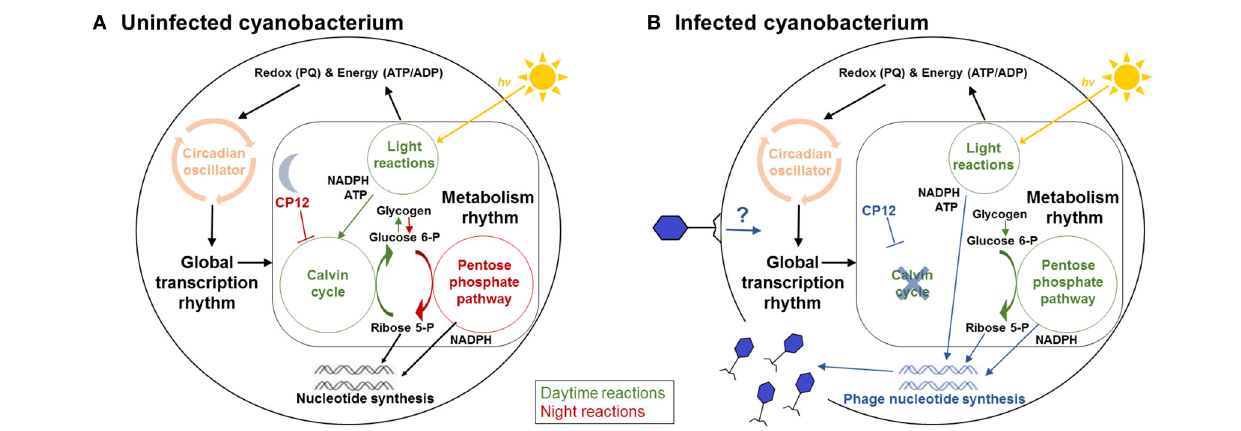
FIGURE 1 | Cyanobacterial metabolism in the uninfected (A) and infected cells (B). (A) In the uninfected host cells, the light reactions of photosynthesis harness energy from the sunlight ( hv ) to produce NADPH and ATP, which are used for carbon fixation in the Calvin cycle. The Calvin cycle is active during the daytime and is inhibited by CP12 at night. The pentose phosphate pathway is mainly active at night. This metabolism rhythm is under the control of the circadian oscillator, which is affected by the intracellular redox (PQ, plastoquinone) and energy (ATP/ADP) state. The reactions with higher activity during the daytime (daytime reactions) are indicated by green color, and ones with higher activity at night (night reactions) are indicated by red color. (B) In the infected host cells, the pentose phosphate pathway is proposed to be active during the daytime, and the Calvin cycle is proposed to be inhibited by phage-encoded CP12 (Thompson et al., 2011). The energy (ATP) and reducing power (NADPH) from the light reactions flow to phage nucleotide synthesis. Reactions that are potentially affected by cyanophages are indicated by blue color. The effects of phage infection on the host’s biological rhythms remain to be